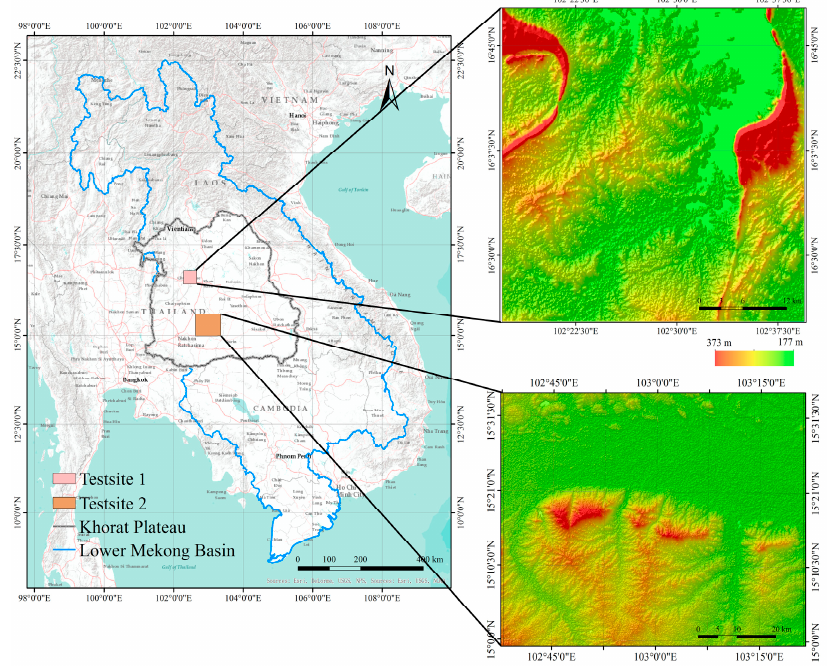
Figure 2. Location of the two test sites.